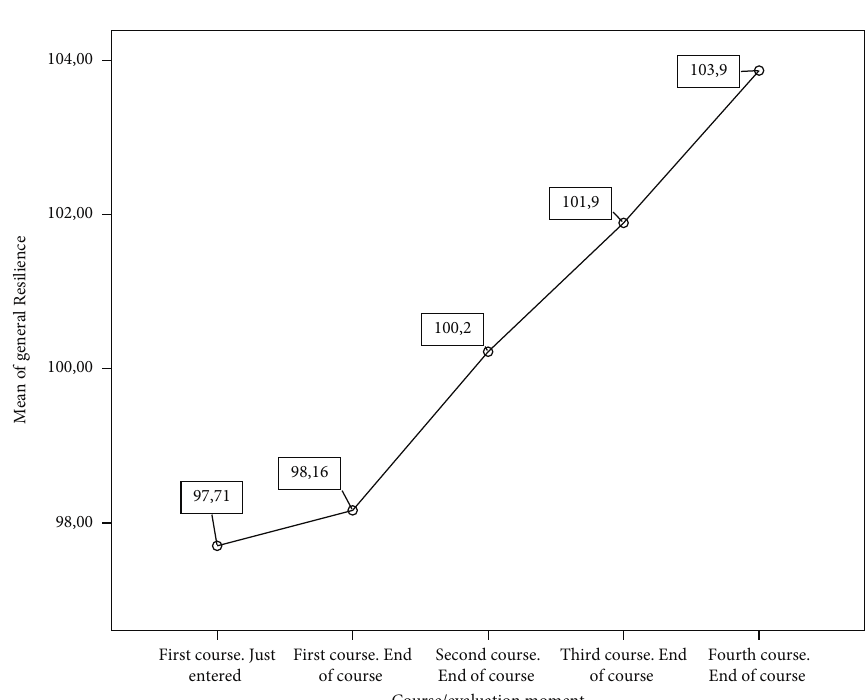
Figure 2: Developmental pattern of resilience in teaching